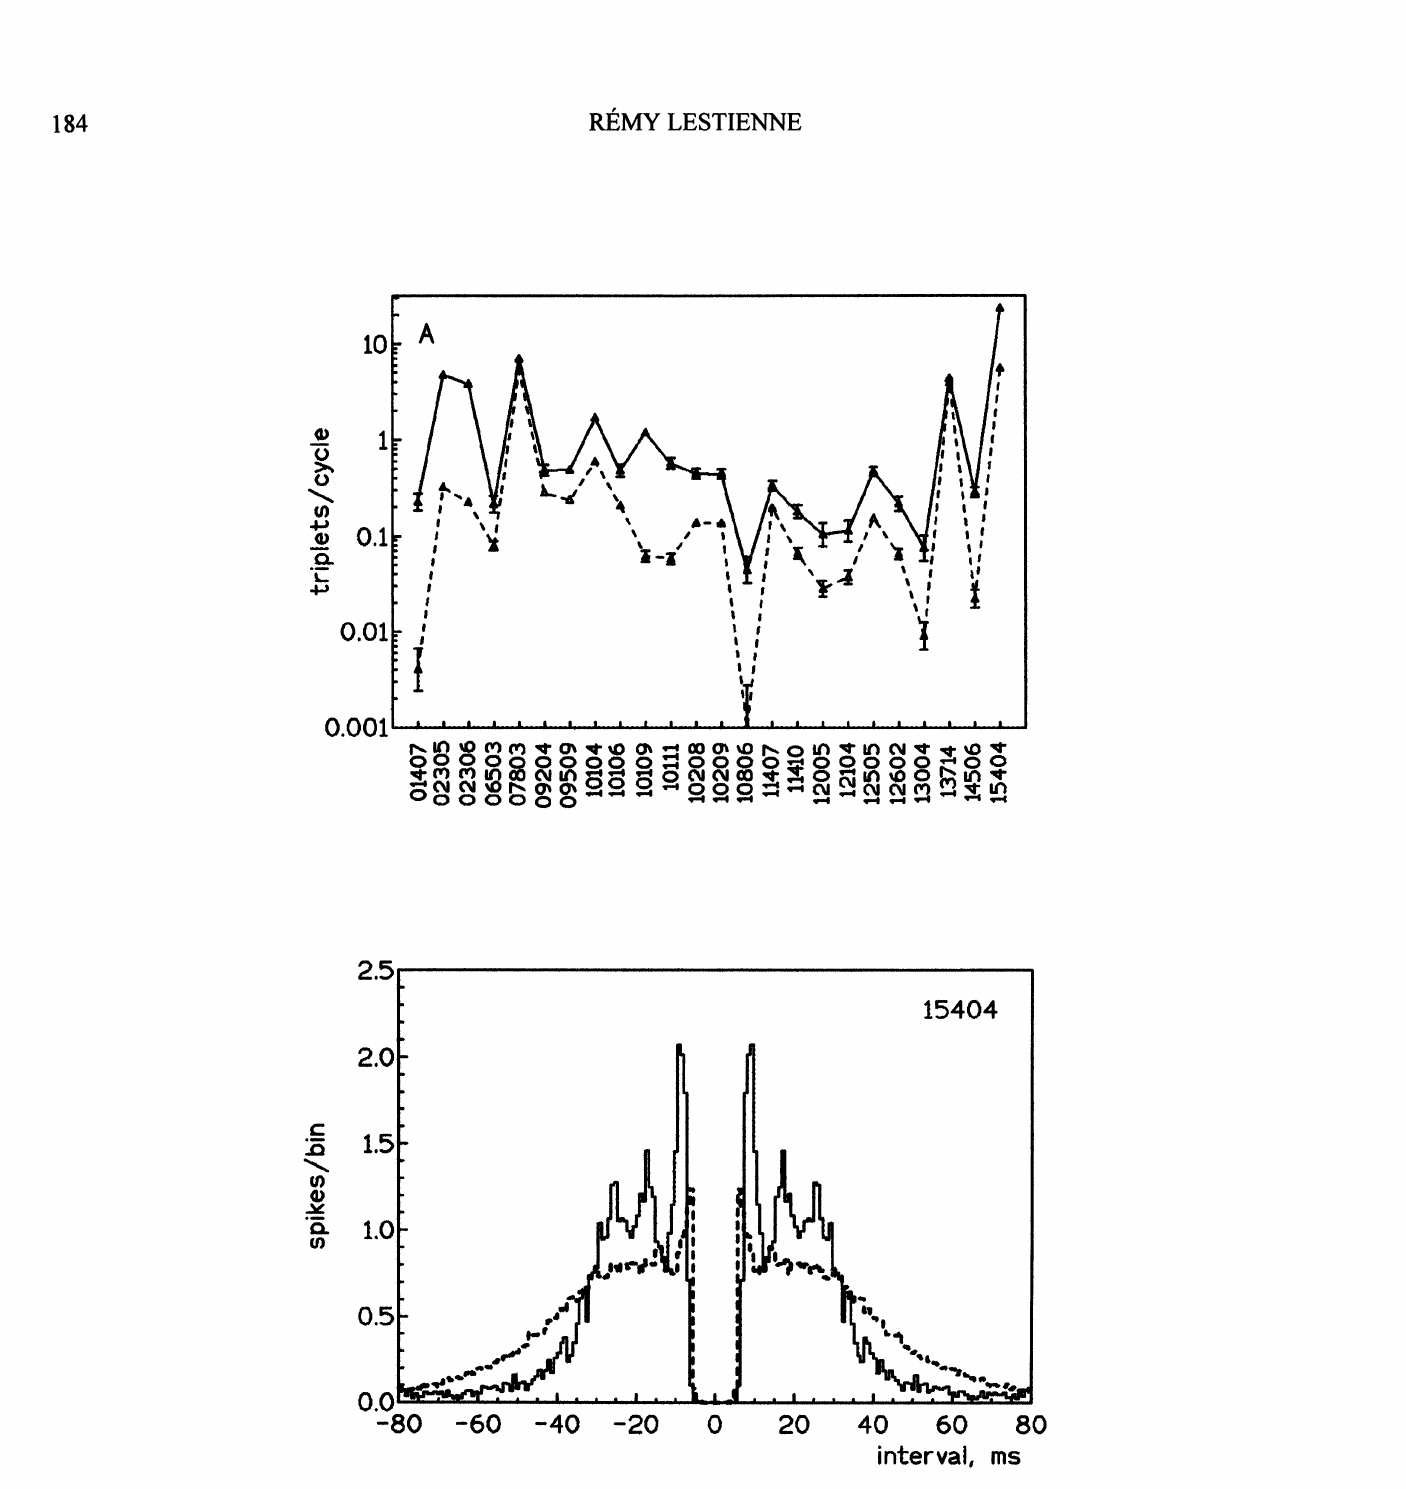
Fig. 8: (A) Detecting replicating triplets in the mitral cell discharges of freely breathing rats. In this collection of 24 records (record labels in abscissa) chosen for their significance (out of 118 records), the rate of production of precisely replicating triplets of spikes (full triangles and full lines) is compared with that in Non Homogeneous Poisson Process (NHPP)-generated spike trains, having the same PSTHs and similar refractory periods (open triangles and broken lines). The logarithmic scale emphases the logarithmic parallelism in the trends of production rates in the two sets of spike trains, and the fact that in physiological data, replicating patterns can be as high as ten times more numerous than in simulations. In the remaining records, where the production of replicating patterns is smaller, there is still a consistent excess of replicating patterns in the physiological data, as compared to simulations. (B) The limited autocorelogram (up to the third other spike in the train) for this record displays the strong temporal organization of the discharge, which is absent in the corresponding NHPP simulation. Such a temporal organization, although reminiscent of oscillations, may in fact reflect the high level of production of repeating patterns of spikes. (From Lestienne et al., 1999; (C)1999 Europ. J.